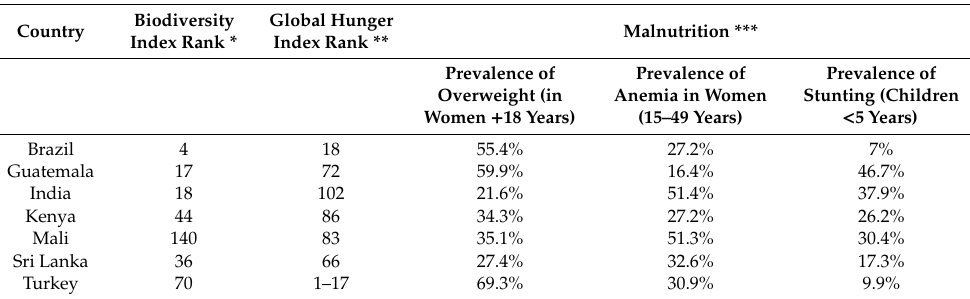
* NBI—The National Biodiversity Index of the Convention on Biological Diversity is based on estimates of country richness and endemism in four terrestrial vertebrate classes and vascular plants. Vertebrates and plants are ranked equally. Index values range between 1.000 (maximum: Indonesia) and 0.000 (minimum: Greenland). The NBI includes adjustments allowing for country size. The values shown are expressed over 161 countries. Countries with land area less than 5000 km 2 are excluded [31]. ** 2019 Global Hunger Index. Based on 117 countries ranked on a 100-point GHI Severity Scale, where 0 is the best score (no hunger) and 100 is the worst [32]. *** Global Nutrition Report country nutrition profiles